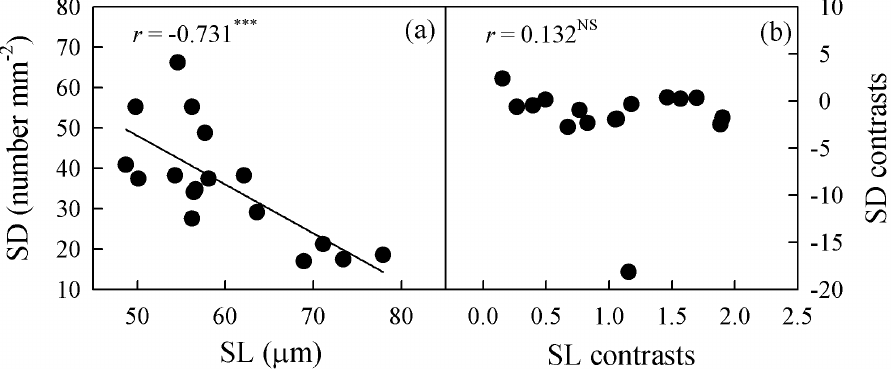
Figure 7. Correlation of stomatal length (SL) with stomatal density (SD) . (a) Pearson’s regression, and (b) phylogenetically independent contrast